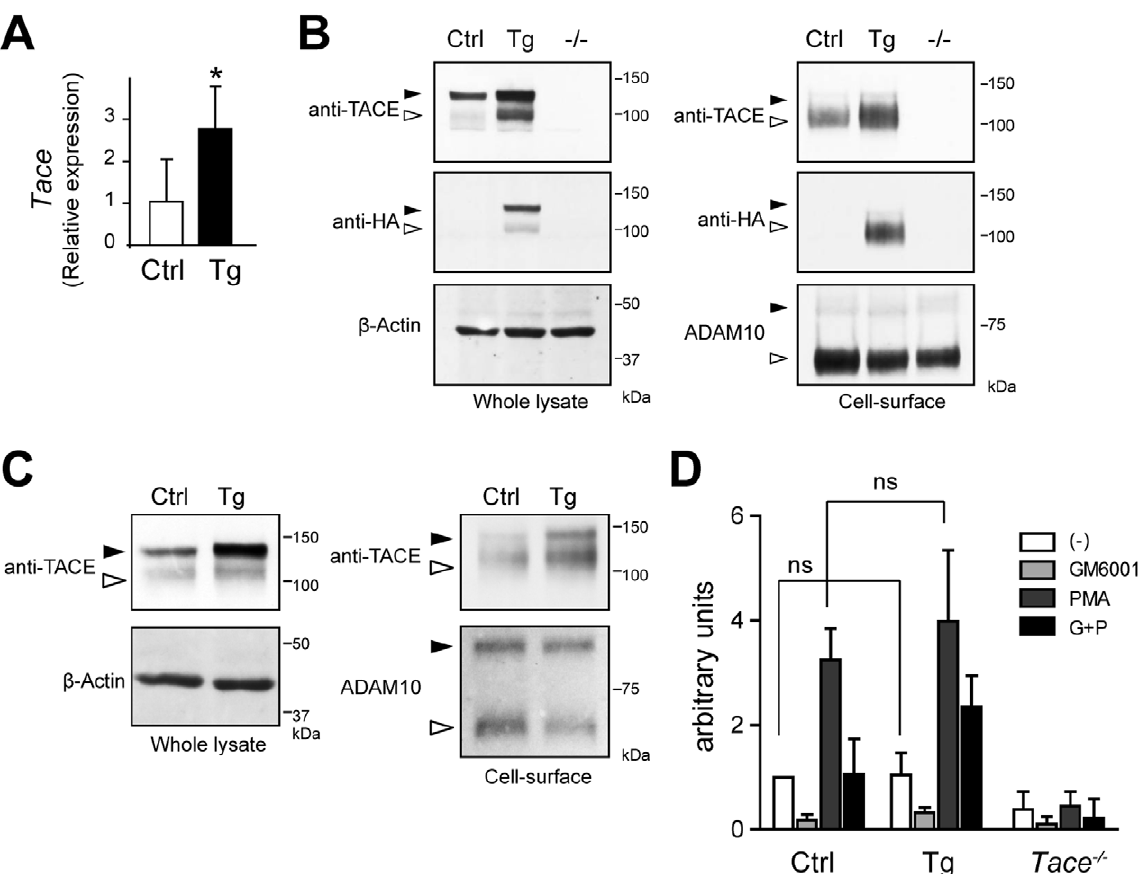
Figure 2. An increase in the mature TACE in Tace -Tg mEFs does not significantly affect the shedding properties of TGF a . (A) Quantitative RT-PCR analysis of Tace expression in the control (Ctrl) and Tace -Tg (Tg)-derived mEFs. (B, C) Cell surface molecules in mEFs (B) derived from control (Ctrl), Tace -Tg (Tg), and Tace 2 / 2 ( 2 / 2 ) mice, and splenocytes (C) derived from control (Ctrl) and Tace -Tg (Tg) were biotin-labeled and analyzed by Western blotting before (Whole lysate) and after (Cell-surface) affinity precipitation with neutravidin beads. The membranes were reprobed with anti- b -Actin antibody and anti-ADAM10 antibody to serve as loading controls for total protein from the whole cell lysate and the cell- surface protein, respectively. Black arrowheads, pro-form. White arrowheads, mature form. Please note that there are small amount of biotinylated pro-form TACE and ADAM10 in panel (C) that were labeled through leakage of the biotin reagent during the procedure. (D) Evaluation of TGF a shedding in the control (Ctrl), Tace -Tg (Tg), and Tace 2 / 2 mEFs by a colorimetric assay. Bars, S.D. *p , 0.05. ns, not